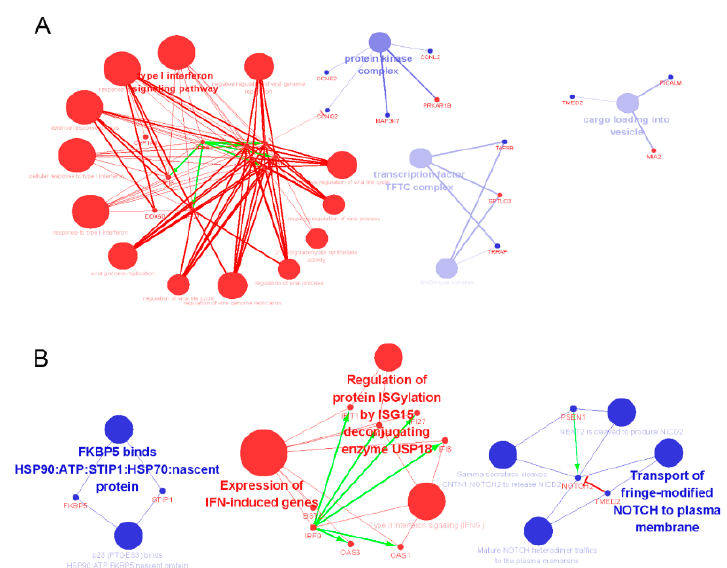
Figure 4. The GO and KEGG enrichment result of DEGs disturbed by bufadienolide-like chemicals. ( A ) Representative biomolecular network of GO enrichment terms. The bigger red nodes imply enrichment of GO terms with up-regulated genes. The bigger blue nodes suggest enrichment of GO terms with down-regulated genes. The small red nodes imply up-regulated genes. The small blue nodes are down-regulated genes. Undirected edges imply enrichment, green directed edges are activated according to the string database. The red directed edges implies suppression from the evidence generated by the String database. ( B ) Representative biomolecular network of KEGG enrichment term, the nodes, and edges also had the same means with Figure 4A.